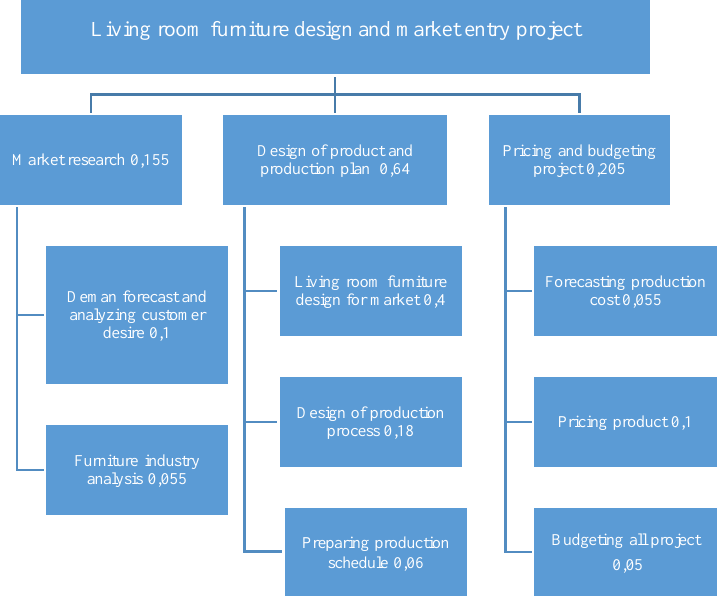
Figure 9. Work breakdown structure of project and priorities of work packages and their